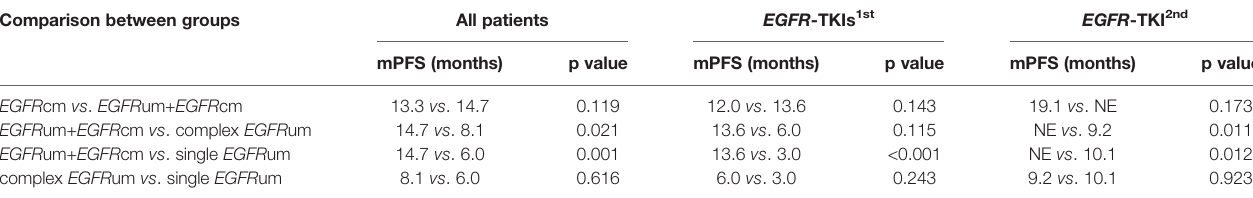
TABLE 2 | Median progression-free survival (mPFS) among patients with different mutation patterns. Comparison between groups All patients